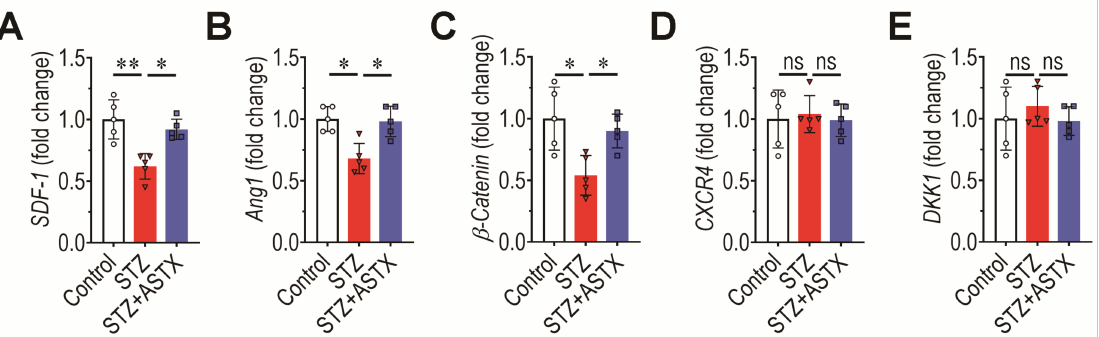
Figure 8. Supplemental ASTX restores mRNA expression of SDF-1, Ang1, and β -catenin in the BM of STZ-injected mice. Expression levels of ( A ) SDF-1 , ( B ) Ang1 , ( C ) β -catenin , ( D ) CXCR4 , and ( E ) DKK1 in whole BM cells were determined at 60 days post-hyperglycemia induction by qRT-PCR ( n = 5/group). * p < 0.05 and ** p < 0.01 by unpaired Student’s t -test. ns, not